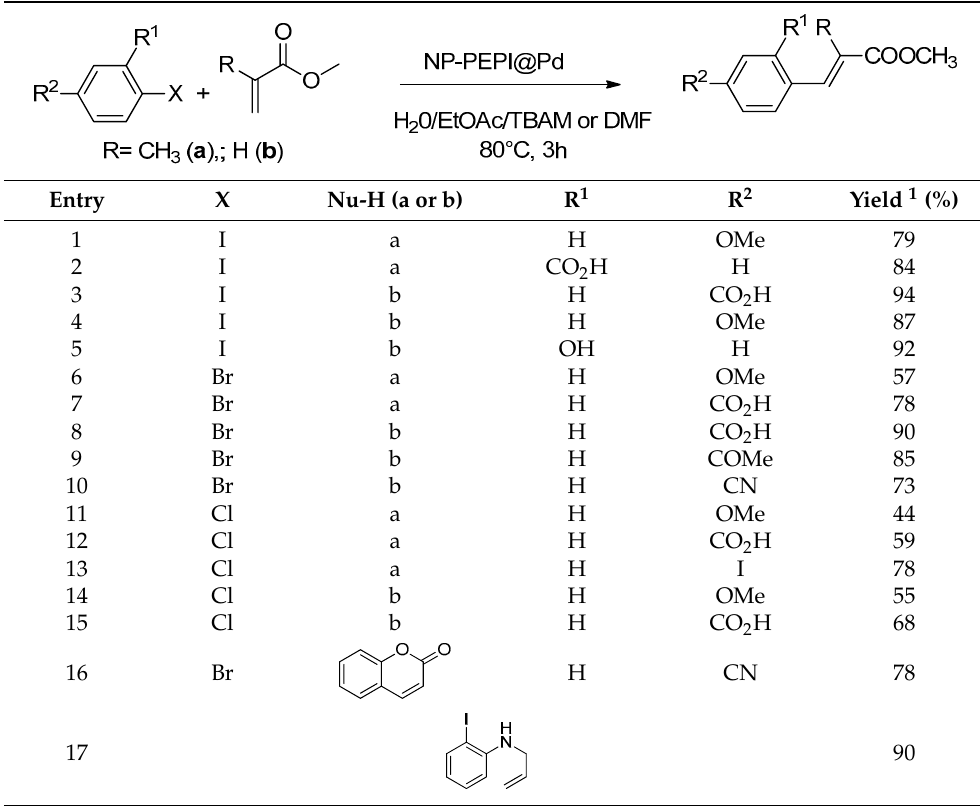
Table 3. Use of NP-PEIP@Pd as catalyst in Mizoroki-Heck couplings.